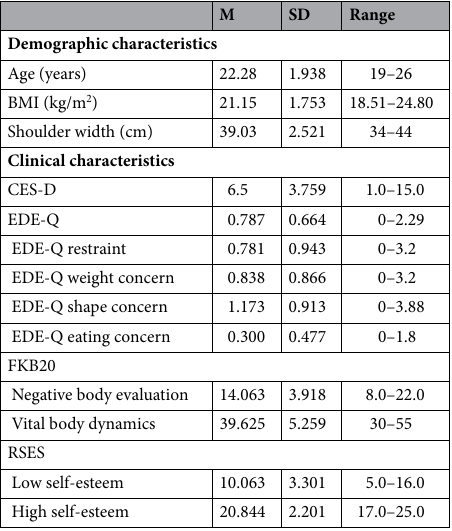
Table 2. Demographic and clinical characteristics. CES-D the Center for Epidemiological Studies Depression Scale 28 , EDE-Q Eating Disorder Examination Questionnaire 29 , FKB20 questions toward the body image 30 , RSES Rosenberg Self-esteem scale 31 , M mean value, SD standard